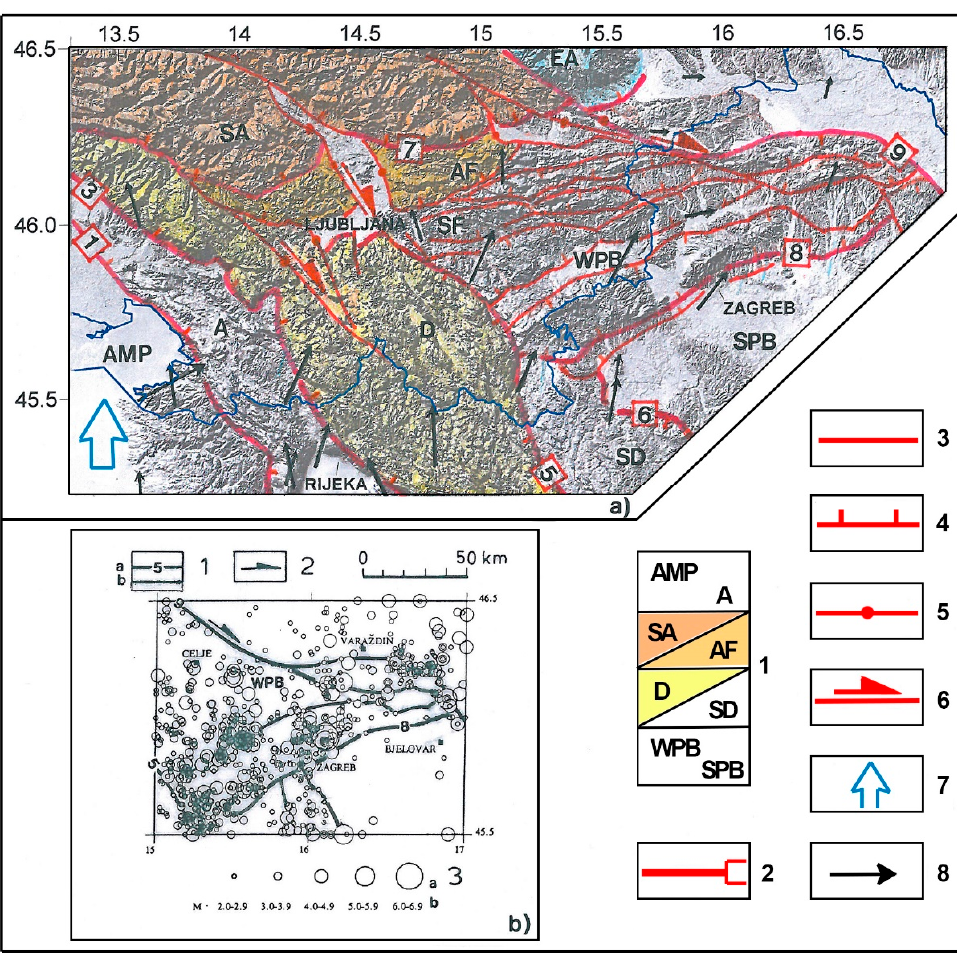
Figure 11. ( a ) Recent geological structural setting and tectonic activity in the contact area of Adriatic microplate, Alps, Dinarides, and Pannonian Basin. Legend: 1—Regional geological structural units: a—Adriatic microplate (AMP) and Adriatic (A) unit, b—Southern Alps (SA), Eastern Alps (EA), Prealps (AF) and Sava faults (SF), c—Dinarides, and Dinarik (D) and Supradinarik (SD) units, d—Pannonian Basin: Western (WPB) and Southern (SPB); 2—major faults adjacent to regional structural units: Trieste–U č ka–Vis fault (1), Ilirska Bistrica–Rijeka–Vinodol fault (3), Fella–Sava fault and continuation of Ljubljana–Karlovac–Slunj (5), southern boundary fault of Pannonian Basin (6), SA fault (7), Zagreb fault (8), Periadriatic fault and continuation of Drava fault (9); 3—other important faults; 4—reverse faults; 5—faults of indeterminate character; 6—the direction of horizontal movement along the fault; 7—movement direction of the Adriatic microplate (AMP); 8—direction of annual velocity at geodetic points in mm/yr. ( b ) Seismic activity: 1a—major faults: Ljubljana–Karlovac–Slunj fault (5), Zagreb fault (8), Periadriatik fault and continuation of Drava fault (9); 1b—other important faults bordering seismotectonically most active structural units in the western part of the Pannonian basin (WPB); 2—the direction of horizontal movement along the fault; 3—earthquake epicentres (a) and earthquake magnitudes (b).